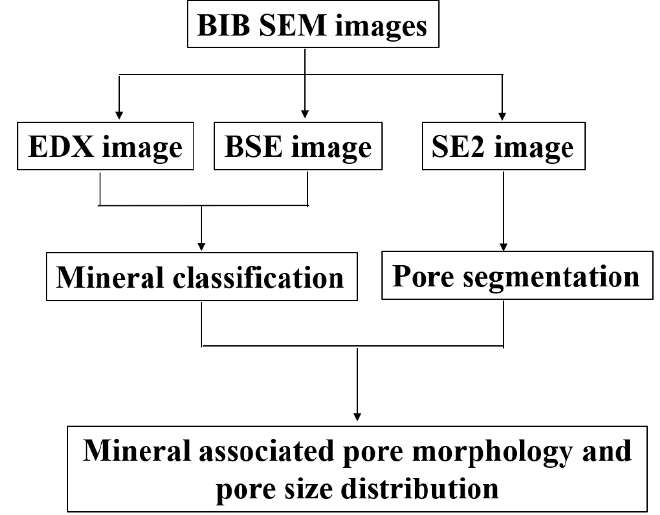
Figure 3. Workflow of BIB-SEM image processing (EDX: energy-dispersive X-ray spectroscopy; BSE: backscattered electron; SE2: secondary electron).